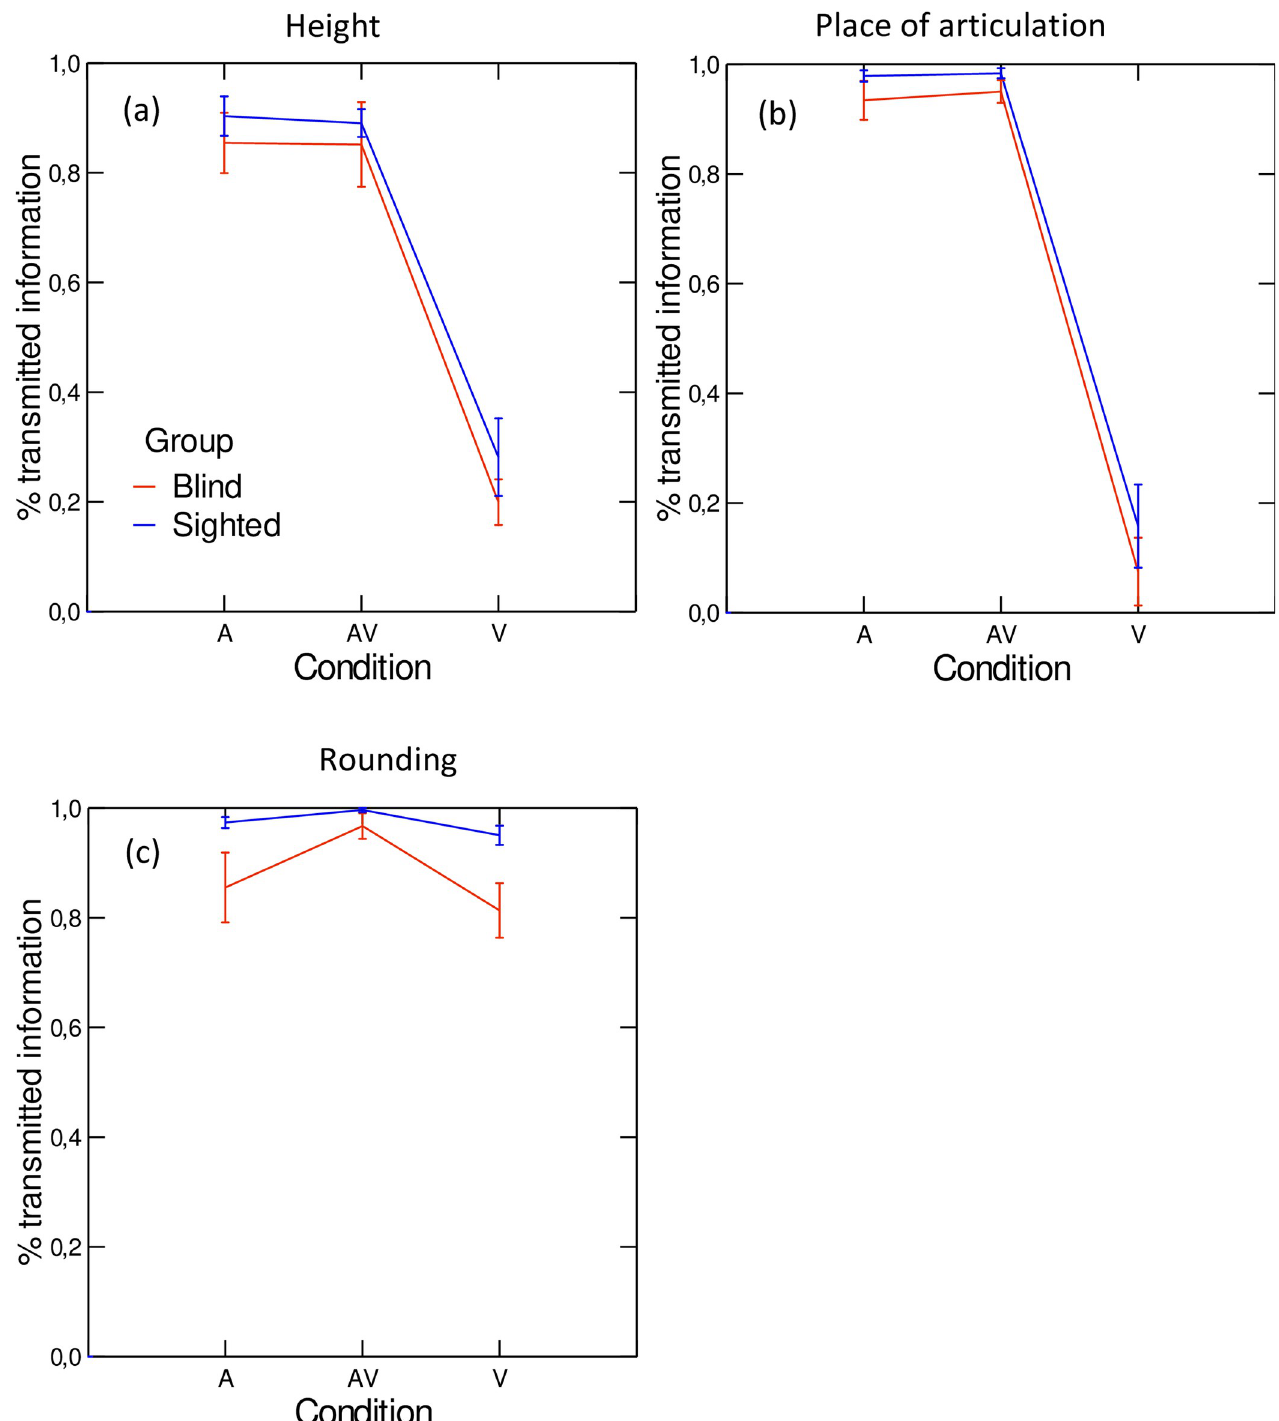
Fig 5. Percentages of transmitted information for each feature (height (a), place of articulation (b), and rounding (c)), in each condition, by speaker group. Error bars represent standard errors.